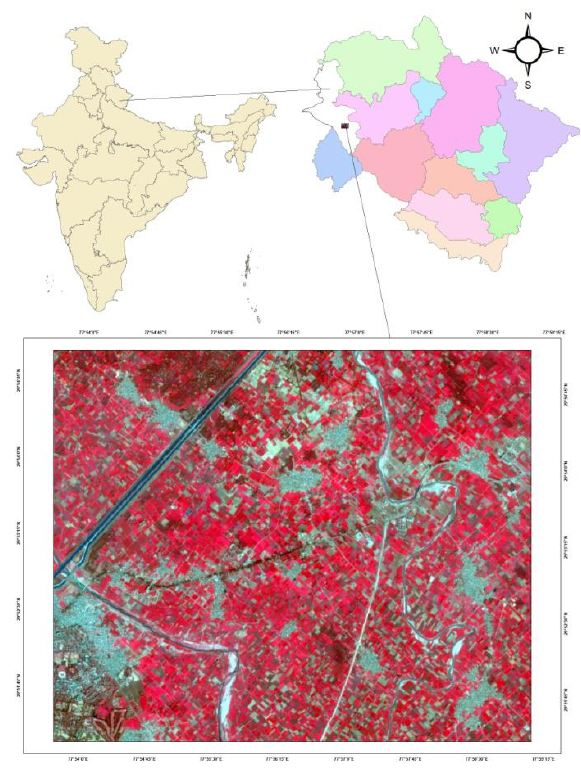
Figure 1. False colour composite of Sentinel-2 image Here, Sentinel-2 multispectral image of 19 February 2018 and Landsat-8 OLI image of 20 February 2018 have been used. In this study, Sentinel-2 bands are considered as two datasets i.e. a 4-band dataset and another is 10-band dataset. The 4-band dataset is formed by using 10 m resolution bands (Red, Green, Blue, NIR) of Sentinel-2 imagery while the 10-band dataset consists of six bands i.e. Red Edge (band-5, 6, 7), Narrow NIR, SWIR (band-11, 12) at 20 m resolution. In order to form 10-band dataset of Sentinel-2, six bands at 20 m resolution are sharpened by adopting Gram-Schmidt algorithm (Colkesen, 2017) using the band selection scheme (Selva, 2015). This band selection scheme selects a band from high resolution (fine resolution) band set for each low resolution band. Band determination is done on the basis of largest correlation with the visited low resolution (Coarse resolution) band (Wang et al. 2016). For OLI dataset